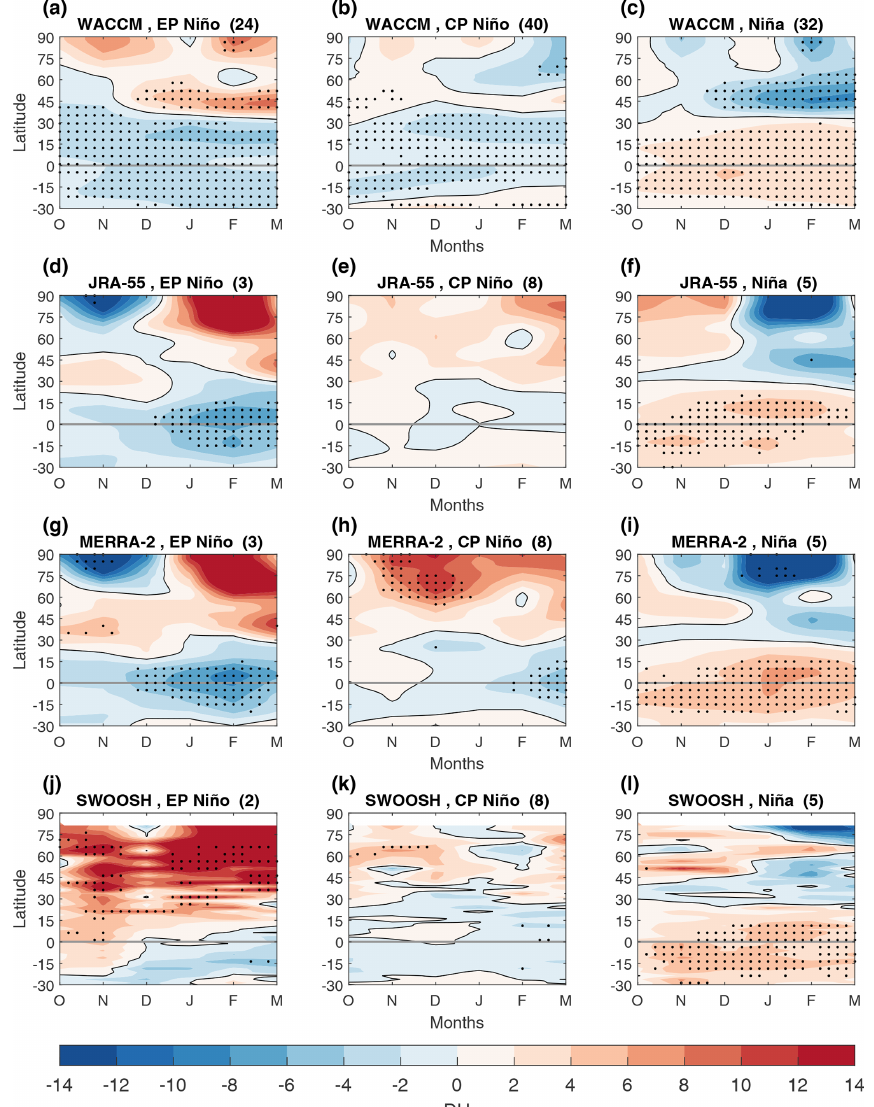
Figure 2. October–March composite evolution of total column ozone (TCO) anomalies (DU, Dobson unit) as a function of latitude in (a–c) WACCM, (d–f) JRA-55, (g–i) MERRA-2 and (j–l) SWOOSH for (from left to right) EP El Niño, CP El Niño and La Niña events. Numbers in parentheses indicate the number of events in each composite. Black dots denote statistically significant anomalies at the 95% confidence